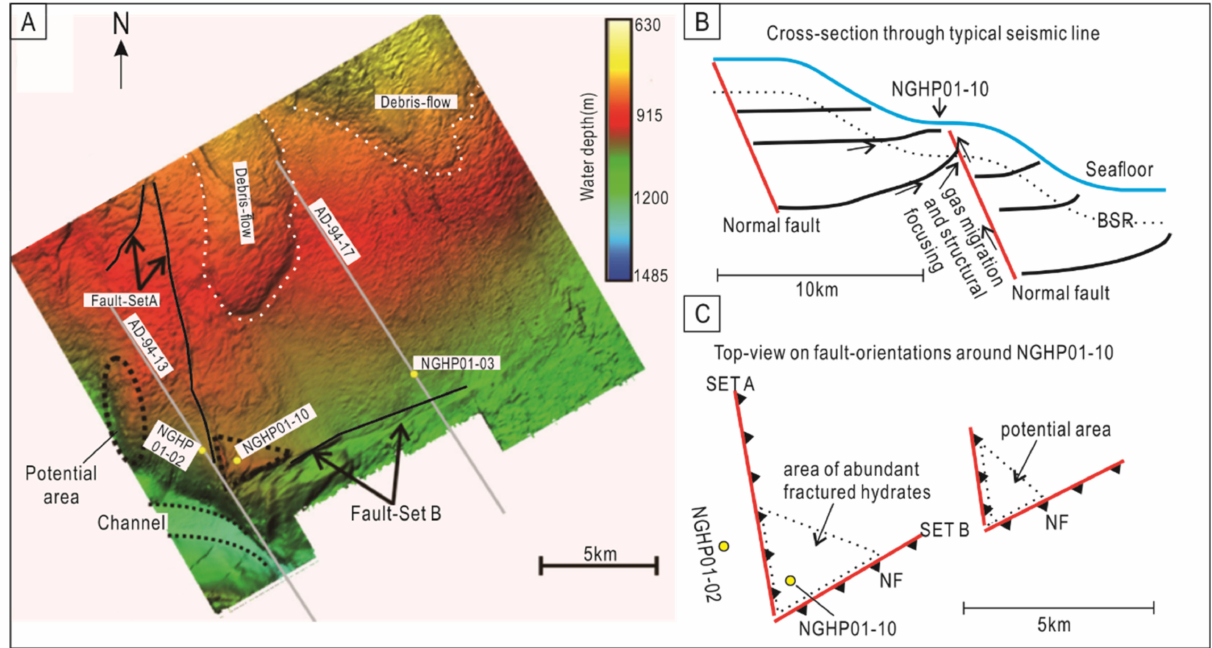
Figure 13. ( A ) A 3D seismic profile showing the detailed seafloor topography surrounding the NGHP- 01-10 site. The two debris flow units lie on top of the surrounding seafloor. ( B ) Diagram illustrating shallow hydrates formation in the KG Basin, which is governed by a diapir-related normal fault. ( C ) Left: A group of normal faults (Sets A and B) creating structural concentrations for ascending free gas that becomes trapped in the corner of the interaction of the fault sets. Right: A potential hydrate area with a similar configuration of faults (summarized from